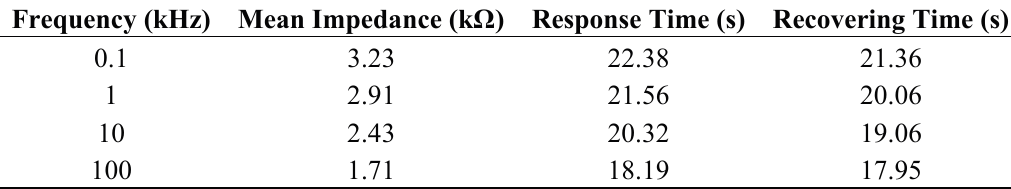
Table 2. Variations of the impedance measurement at 250